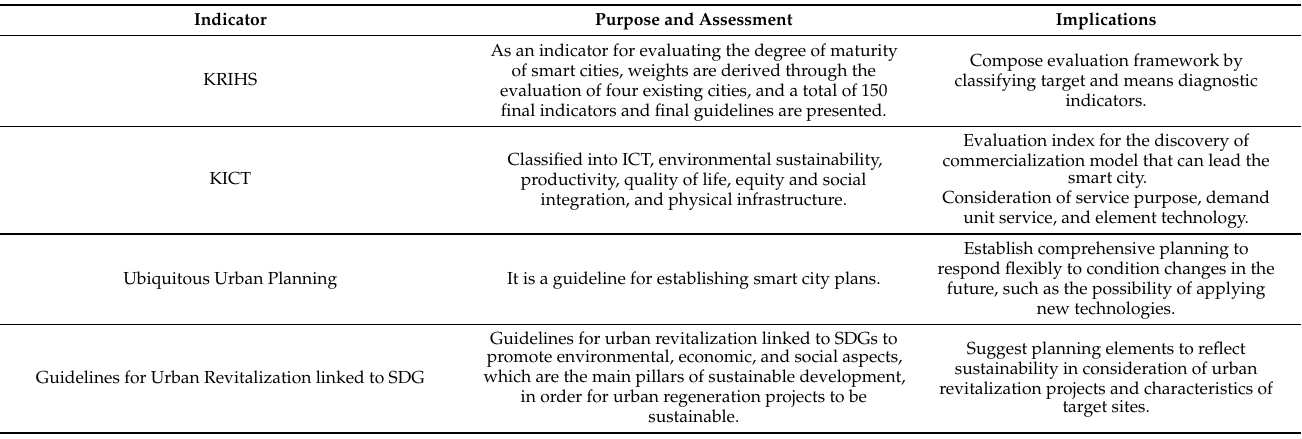
Table A2. Indicator